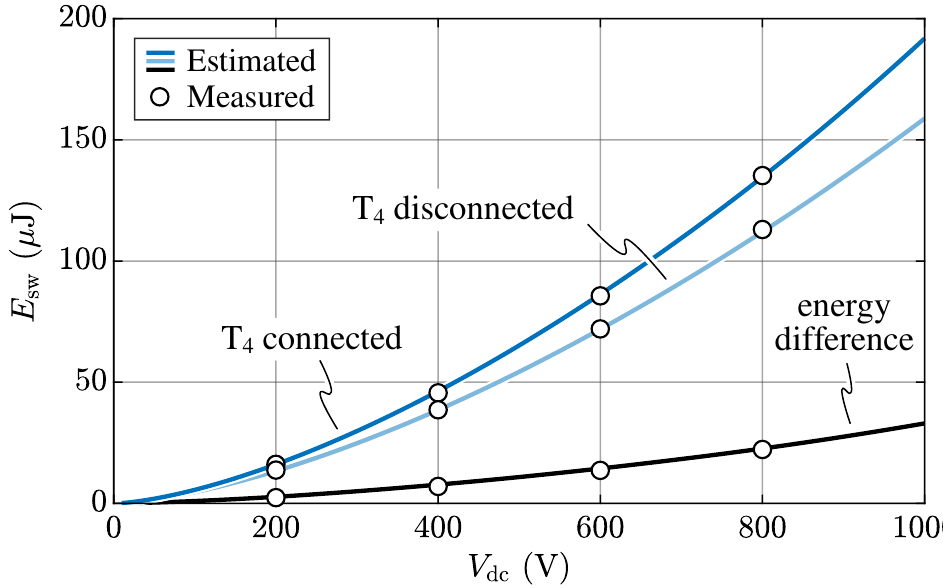
Figure 4. Comparison between estimated and measured zero output current losses in the 3LTT bridge-leg (T 1 = T 4 : C3M0032120K, T 2 = T 3 : C3M0025065K) as a function of the DC-link voltage V dc . The results are obtained by switching T 1 ↔ T 2 : the additional energy loss related to the charg- + E ing/discharging of C oss,T (i.e., E c,T d,T 4 ) is indicated in black. The estimated energy losses take 4 4 into account the measured parasitic capacitance C σ ≈ 35pF between the switching node and the DC-link as E σ = 2 · 1 / 2 C σ V 2 sw